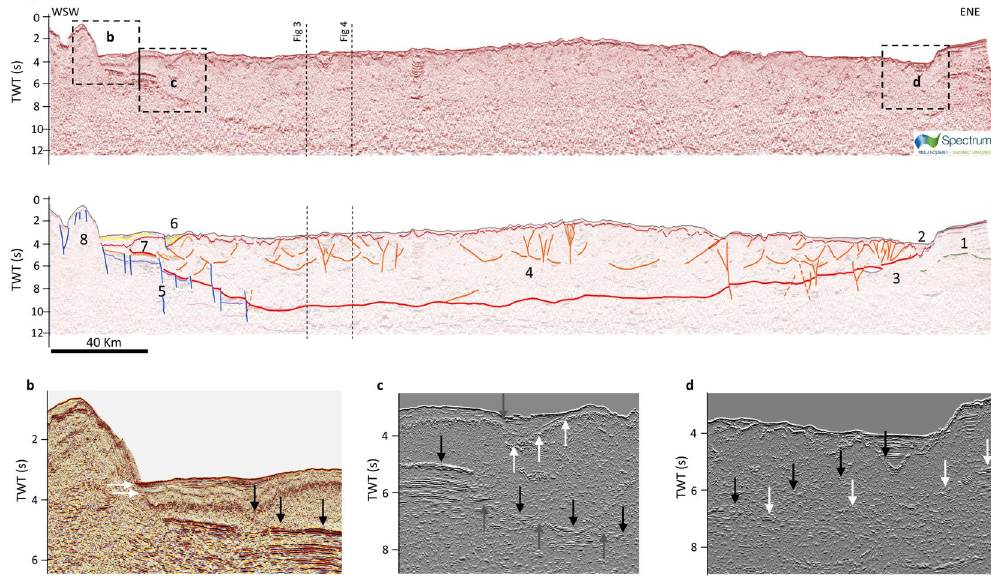
Figure 5. SW-NE seismic profile interpretation. Panel a - Seismic profile (profile #14 in Supplementary Figure S3). Horizon colour codes as in Fig. 2. Description of units (U1-9) and bounding horizons (H1-7) are reported in Table 2 and Table 3, respectively. Yellow lines: unconformities within the Plio-Holocene basins (U1). Structural elements: Orange lines: contractional structures within the accretionary wedge. Red lines: subduction interface. Dark blue lines: extensional or transtensional faults. Key elements for the interpretation: 1 – Apulia Platform (U8); 2 – Plio-Holocene foredeep; 3 – U8 at the footwall of the outer accretionary wedge (U6); 4 – Accretionary wedge (U6); 5 – Subduction Transform Edge Propagator (STEP) fault system; 6 – Syn-tectonic Plio-Holocene extensional basin related to the STEP fault; 7 – Post-Messinian wedge; 8 – Hyblean Platform (U9). Dashed vertical lines indicate the intersection with profile #7 (Fig. 4 and Supplementary Figure S2) and profile CROP M2B (Fig. 3). Panel b - Detail of the seismic line showing the position of the subduction interface (black arrows) and show the stratigraphic onlap of the undeformed U1 (to the left) onto the Malta Escarpment (to the right; Fig. 6). Panel c - Detail of the seismic line in a display using the energy attribute showing the position of the subduction interface (black arrows) and its local displacement by sub-vertical faults (grey arrows pointing up), and the unconformity H2 (white arrows) deformed by a shallow normal fault (grey arrow pointing down). Panel d - Detail of the seismic line in a display using the energy attribute showing the position of the subduction interface (black arrows), and the position of a high-energy reflector within U8 followed under the subduction interface (white arrows). Raw seismic data provided by Spectrum Geo